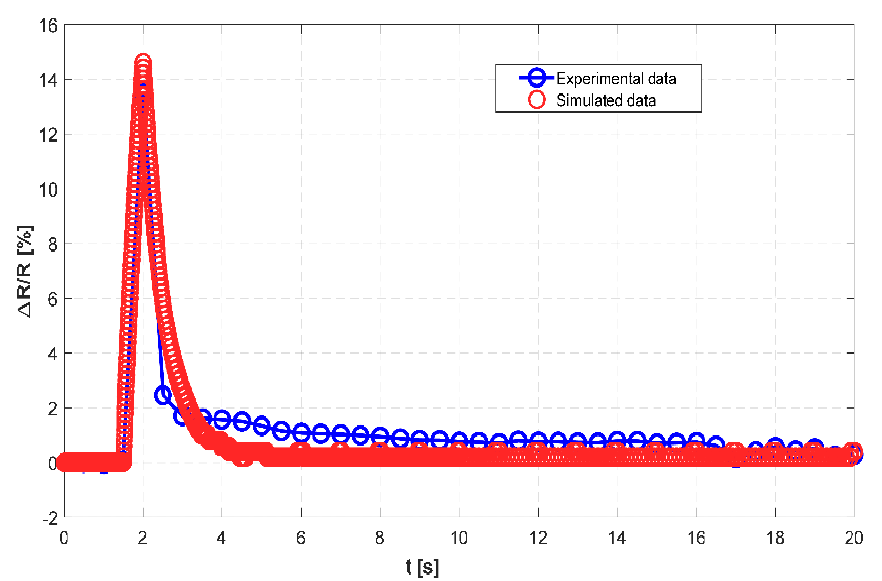
Figure 6. Simulated and experimental data of normalized resistance change upon a single writing pulse.